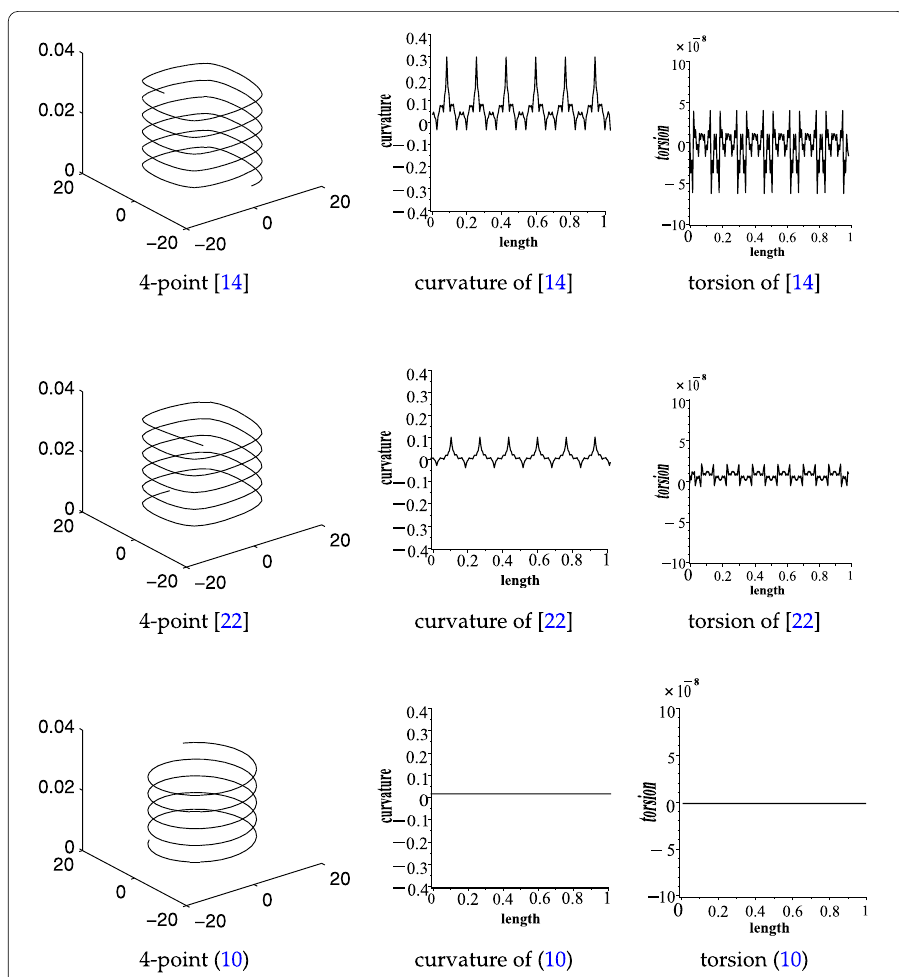
Figure 2 Limit curves obtained after the fifth iteration, the corresponding curvature (center) and torsion